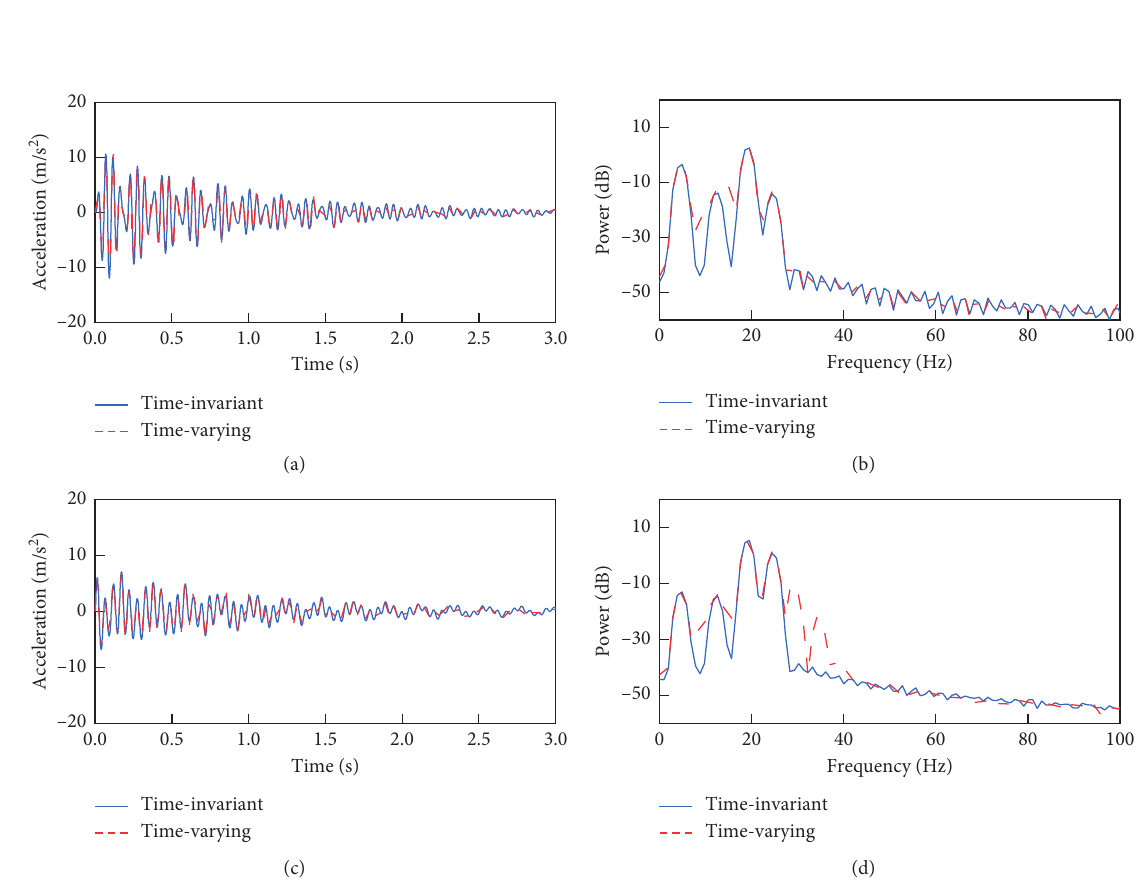
Figure 7: The comparison of the time domain and power spectral density in time-varying and time-invariant signals of the system.